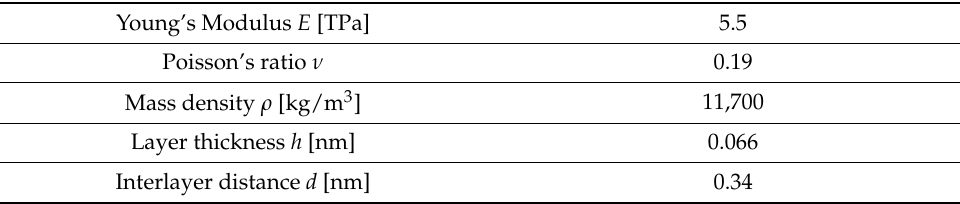
Table 1. Mechanical parameters of the considered DWCNTs